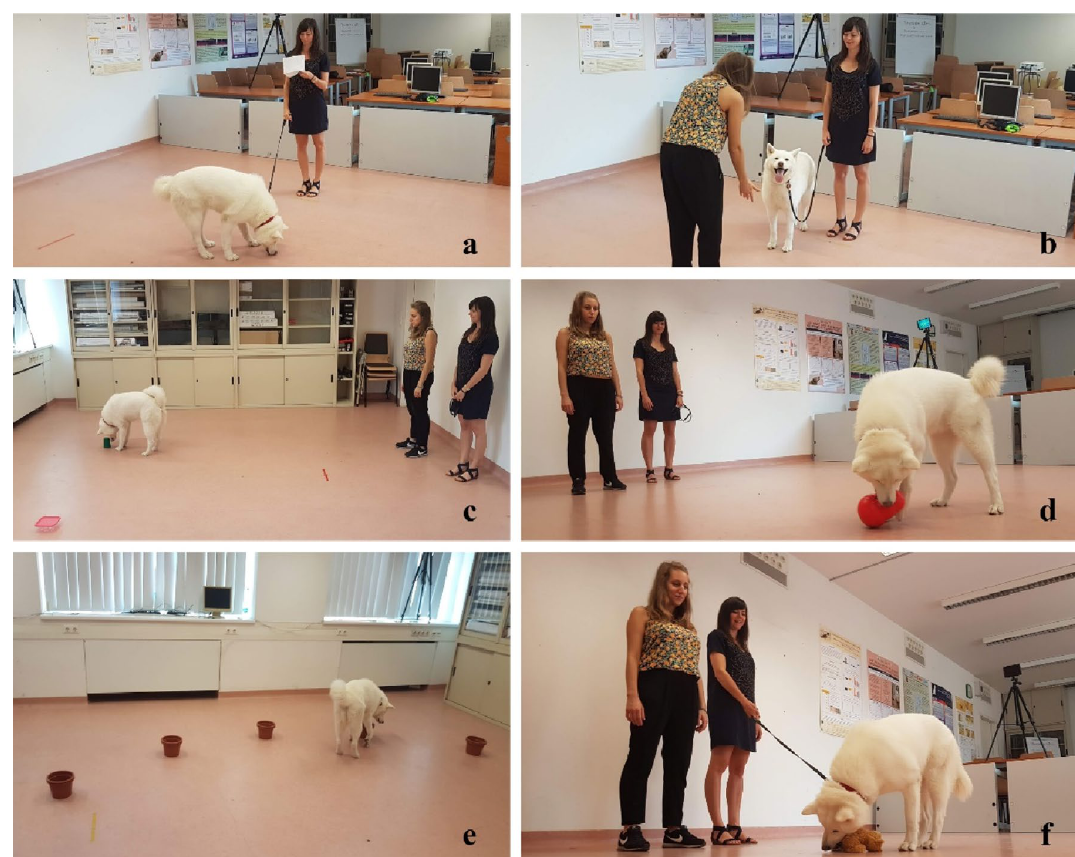
Figure 1. Behavioural tests of the test battery. ( a ) Exploration; ( b ) Greeting; ( c ) Novel object recognition; ( d ) Problem box; ( e ) Memory; ( f ) Novel object (toy